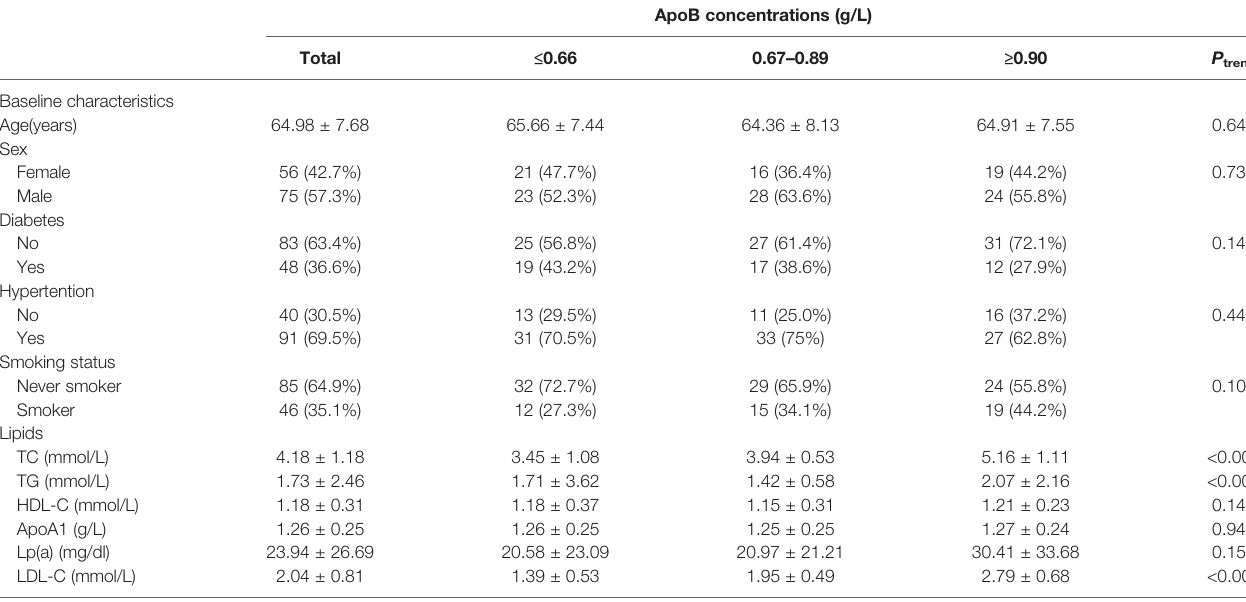
TABLE 1 | Baseline characteristics of participants with statins treatment according to ApoB